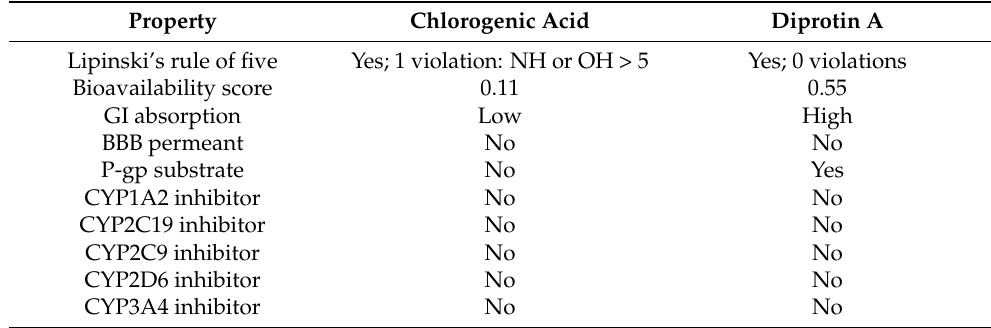
Table 3. Drug-likeness and absorption, distribution, metabolism, and excretion (ADME) properties of chlorogenic acid and Diprotin A based on gastrointestinal absorption, blood–brain barrier permeation, possible P-gp substrate, and possible cytochromes enzyme inhibition. Property Chlorogenic Acid Diprotin A Lipinski’s rule of five Yes; 1 violation: NH or OH > 5 Yes; 0 violations Bioavailability score 0.11 0.55 GI absorption Low High BBB permeant No No P-gp substrate No Yes CYP1A2 inhibitor CYP2C19 inhibitor